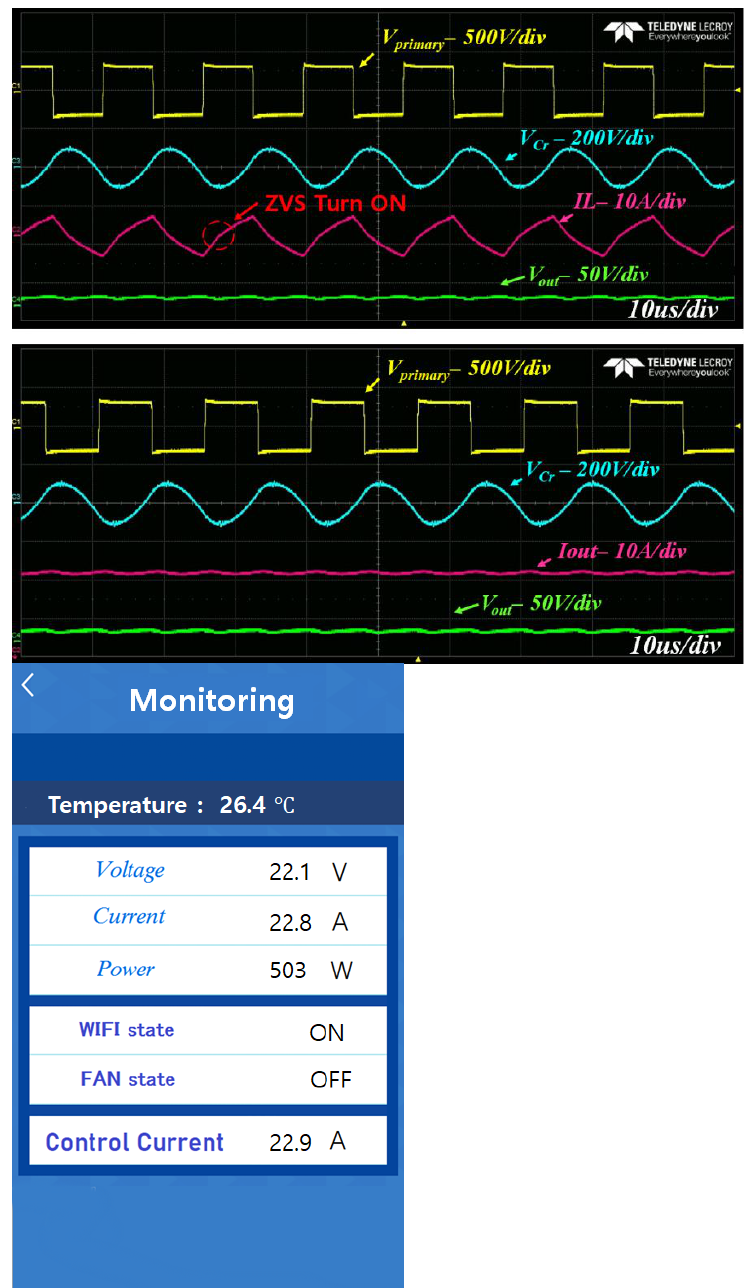
Figure 11. Charging wave form and corresponding smartphone application screen snapshots (Auto mode, Temperature = 26.4 °C.